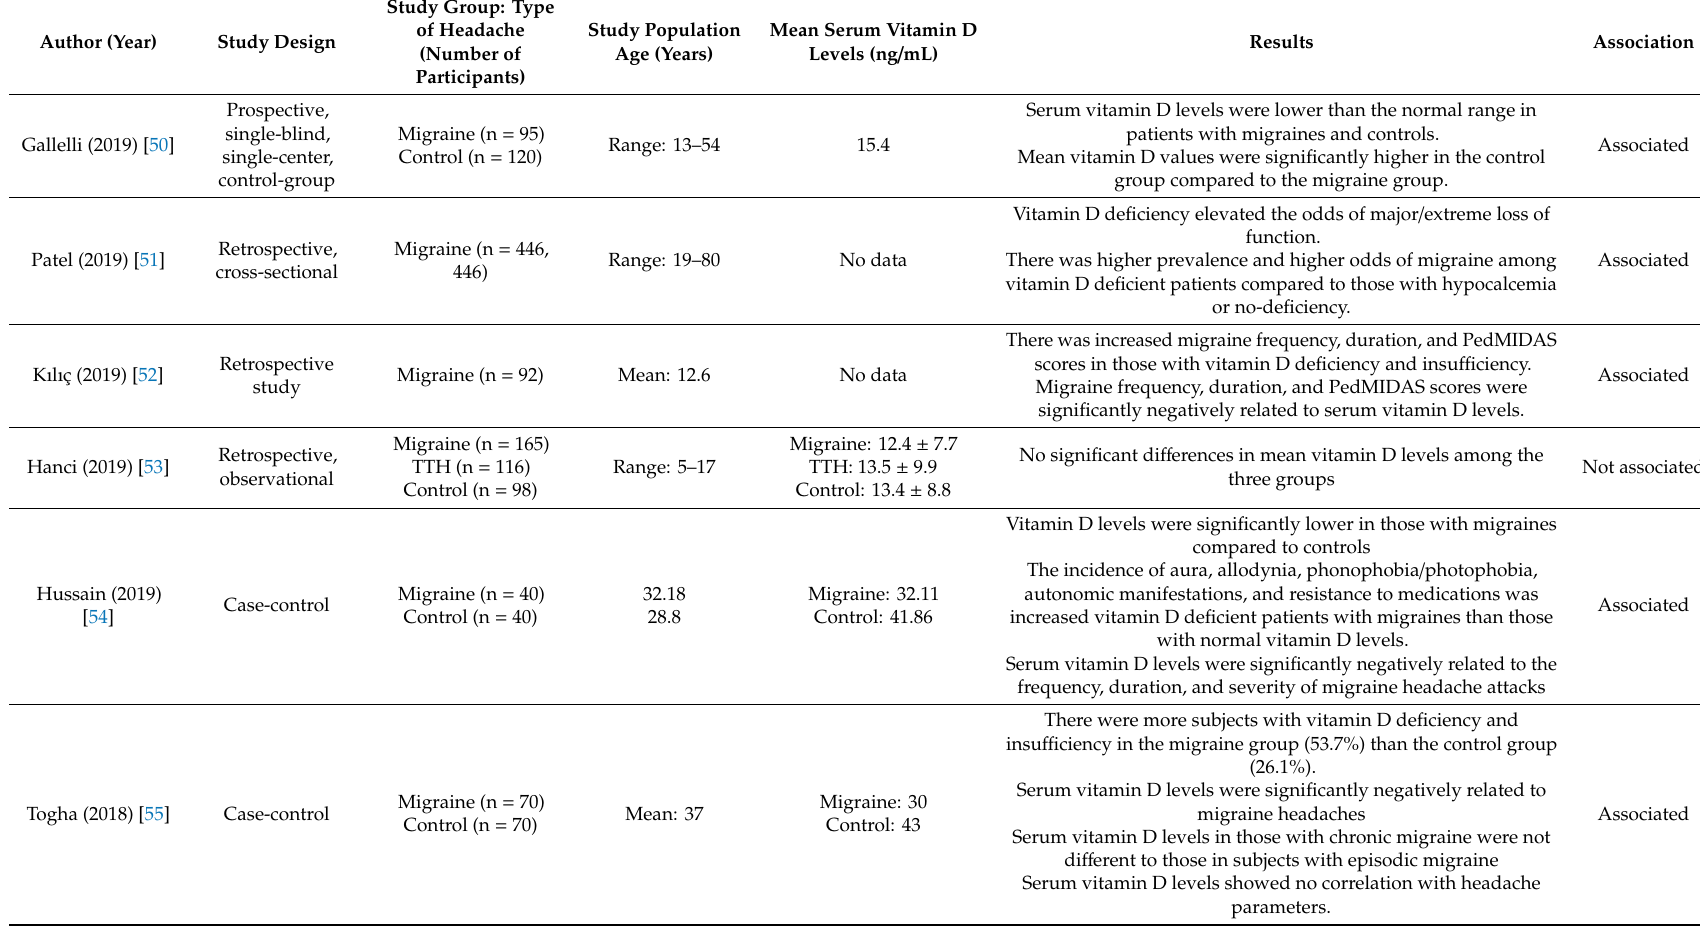
Table 1. Overview of studies investigating vitamin D serum levels in association with